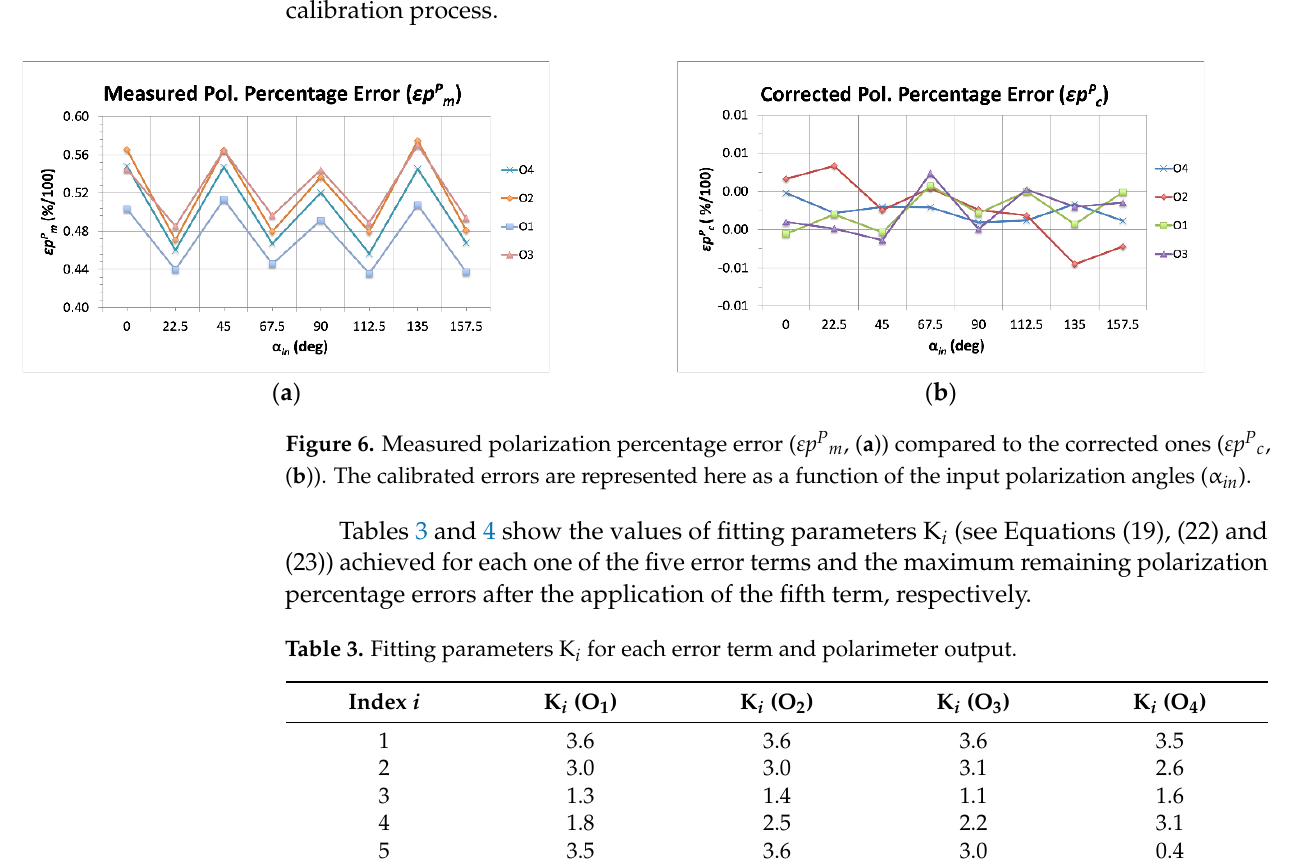
Table 4. Maximum remaining error after calibration using five error terms.